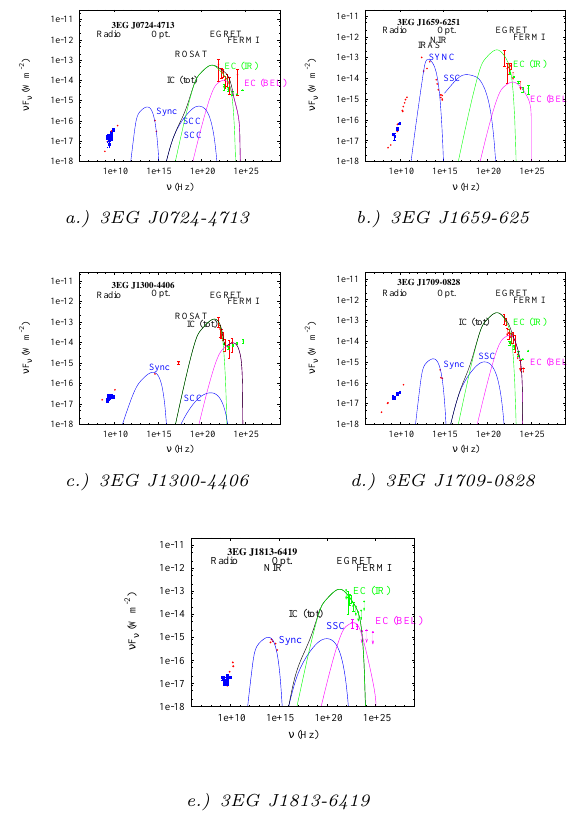
Figure 8: The modeled SEDs for the various EGRET / Fermi-LAT